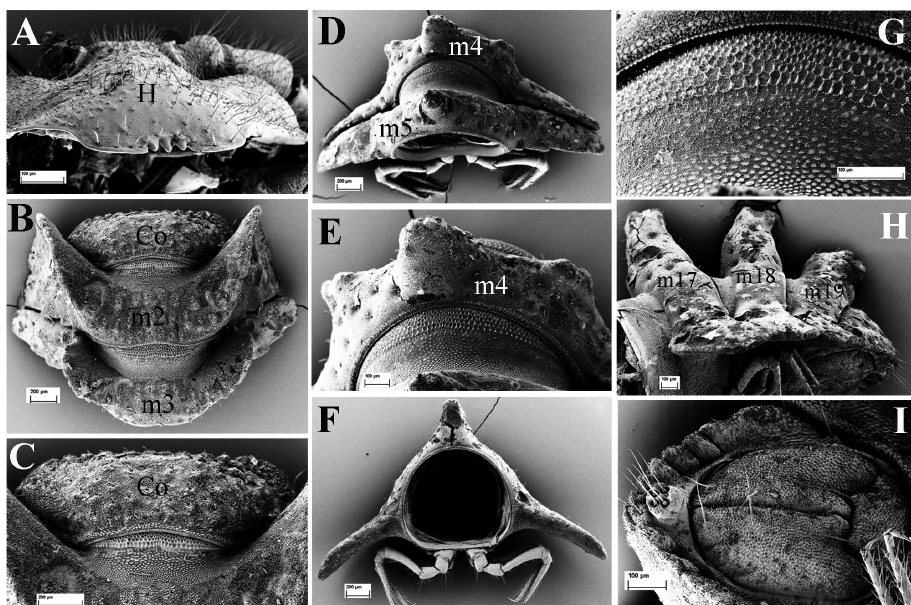
Figure 8. E. paraster sp. n., SEM, male holotype from Cave Tham Long Puang. A head (H), subfrontal view B collum (Co) and segments 2–3 (m2–m3 = metaterga 2, 3), dorsal view C collum (Co), dorsal view D segments 4 and 5 (m4–m5 = metaterga 4, 5), dorsal view E segment 4 (m4 = metatergum 4), dorsal view F cross-section of segment 6, caudal view G prozonum 5, dorsal view H segments 17–19 and telson, lateral view (m17–m19 = metaterga 17–19) I telson, ventral